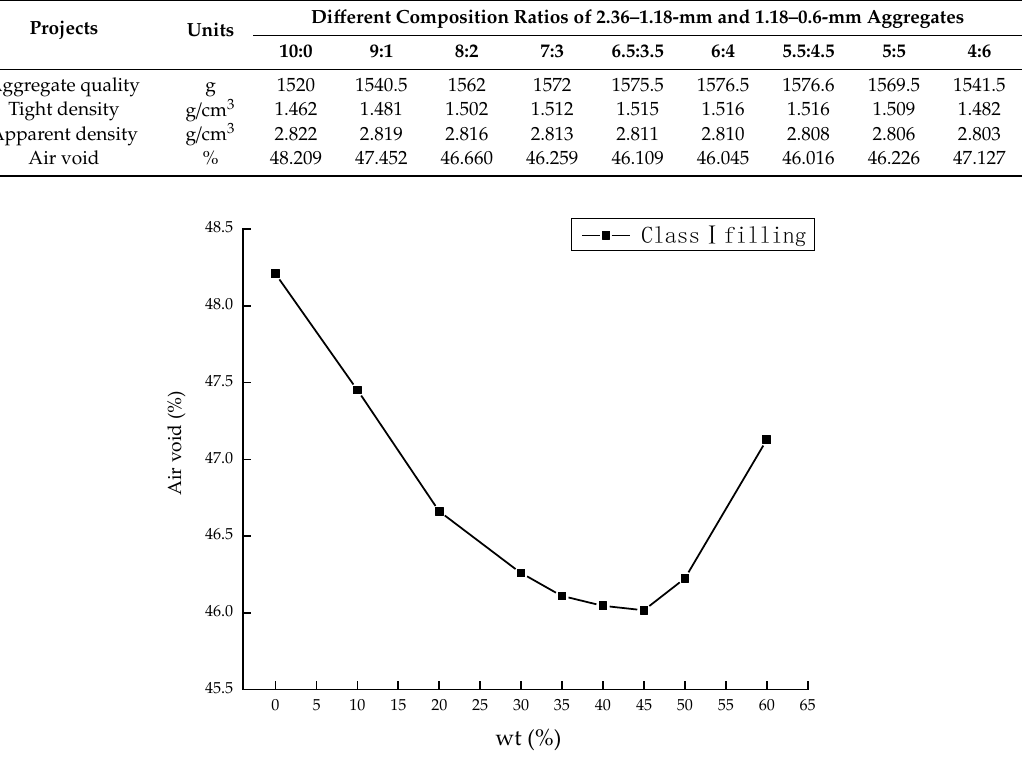
Figure 3. Air void at different ratios of 2.36–1.18 mm and 1.18–0.6 mm.